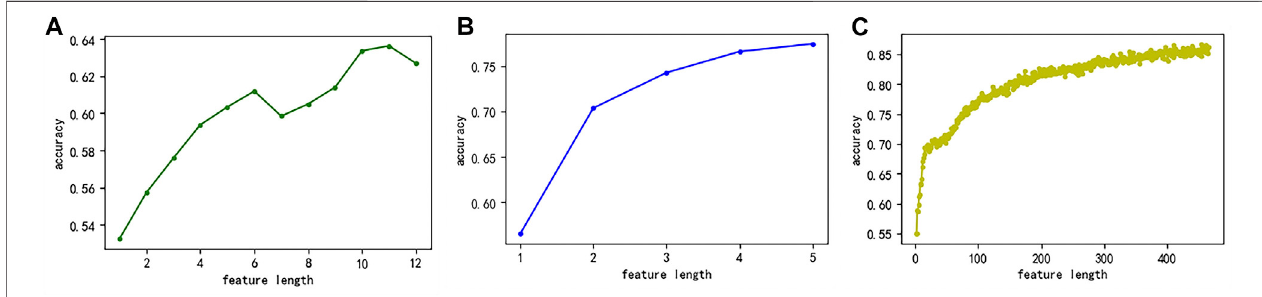
FIGURE 7 | The relationship between the number of features extracted by the three methods and the accuracy of predicting potentially druggable proteins (A) CC (B) GAAC, and (C) monoDiKGap.